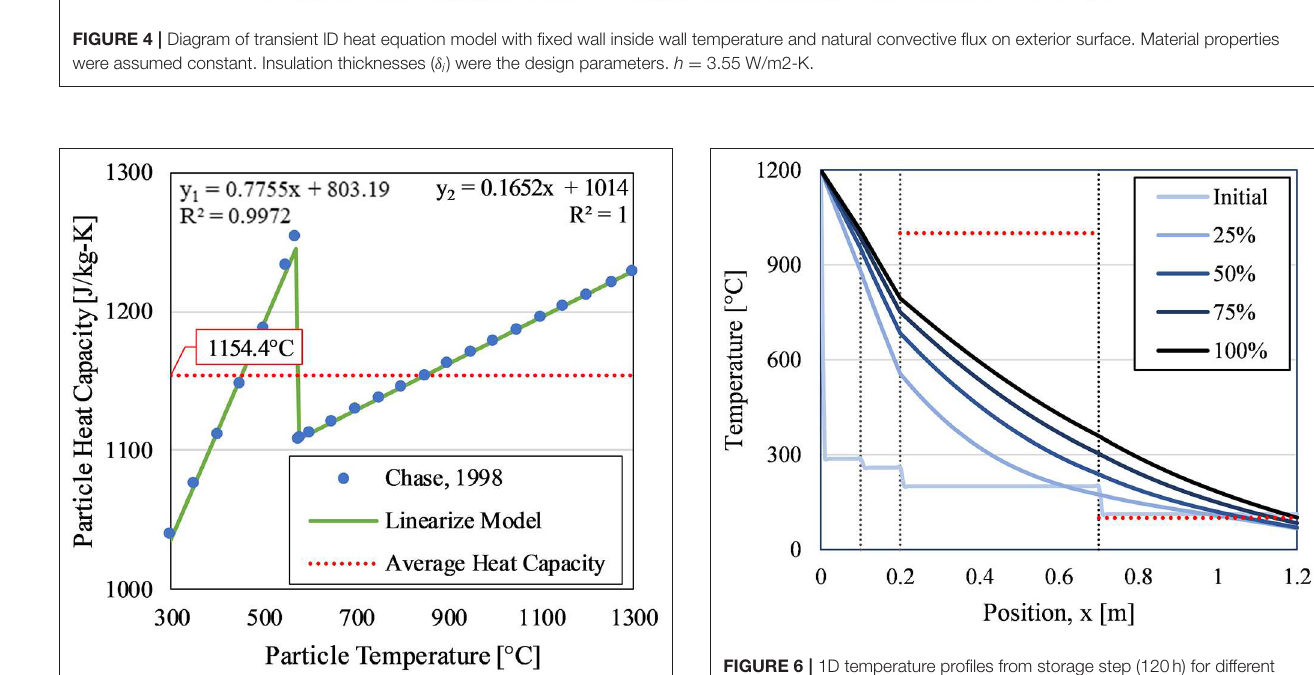
FIGURE 6 | 1D temperature profiles from storage step (120h) for different points in time from exemplary case (Refractory A = 0.1m, Refractory B = 0.1m, CaSi = 0.5m, concrete = 0.5m). Vertical lines mark changes in insulation material. Horizontal red lines mark material temperature limits for CaSi (1,000 ◦ C) and concrete (100 ◦